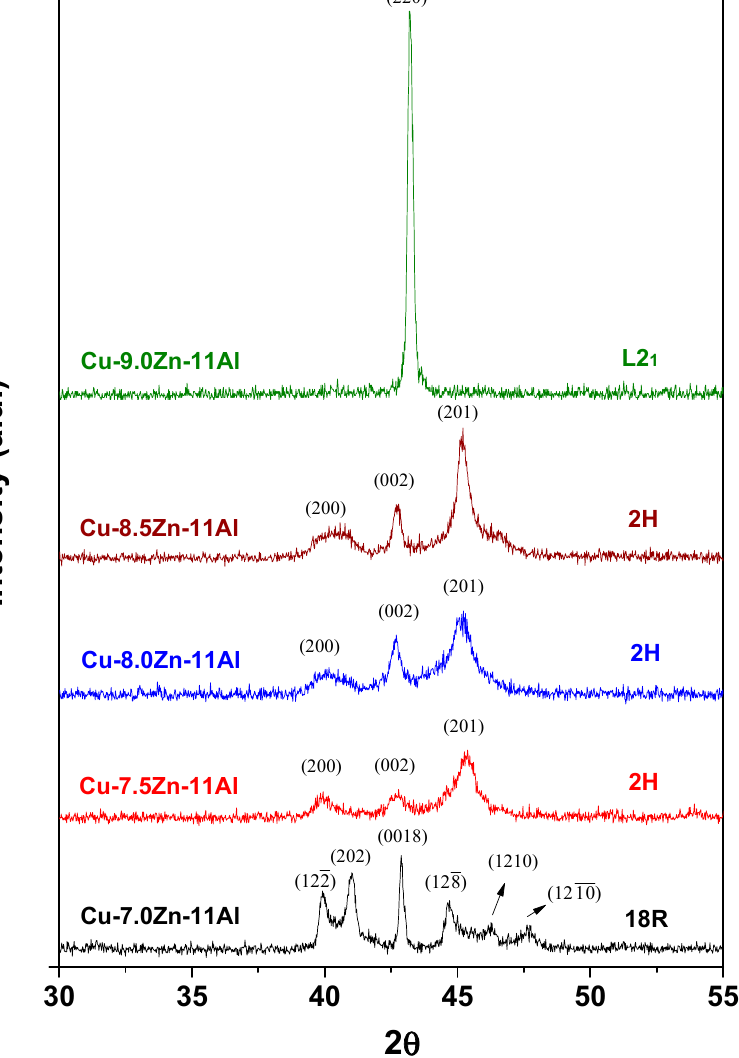
Figure 1. XRD patterns for Cu-xZn-11Al SMAs with various Zn contents.